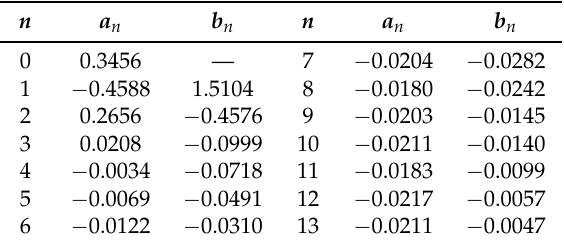
Table 1. The coefficients of Equation (1). Table1. The coefficients of Equation (1). Table1. The coefficients of Equation (1).